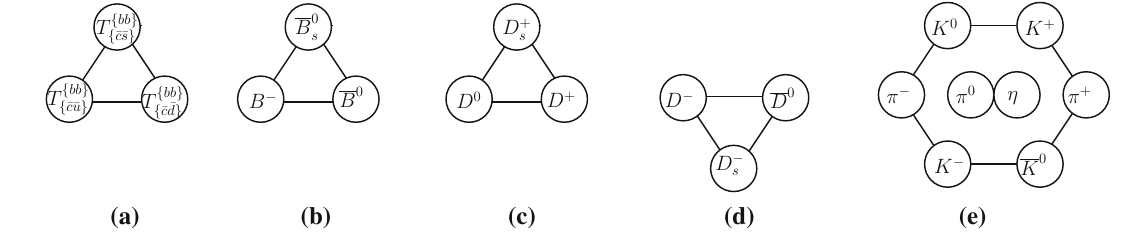
{ bb } Fig. 1 The weight diagrams for the tetraquark T {¯ c ¯ q } , bottom meson and charmed meson anti-triplet, anti-charmed meson triplet and light